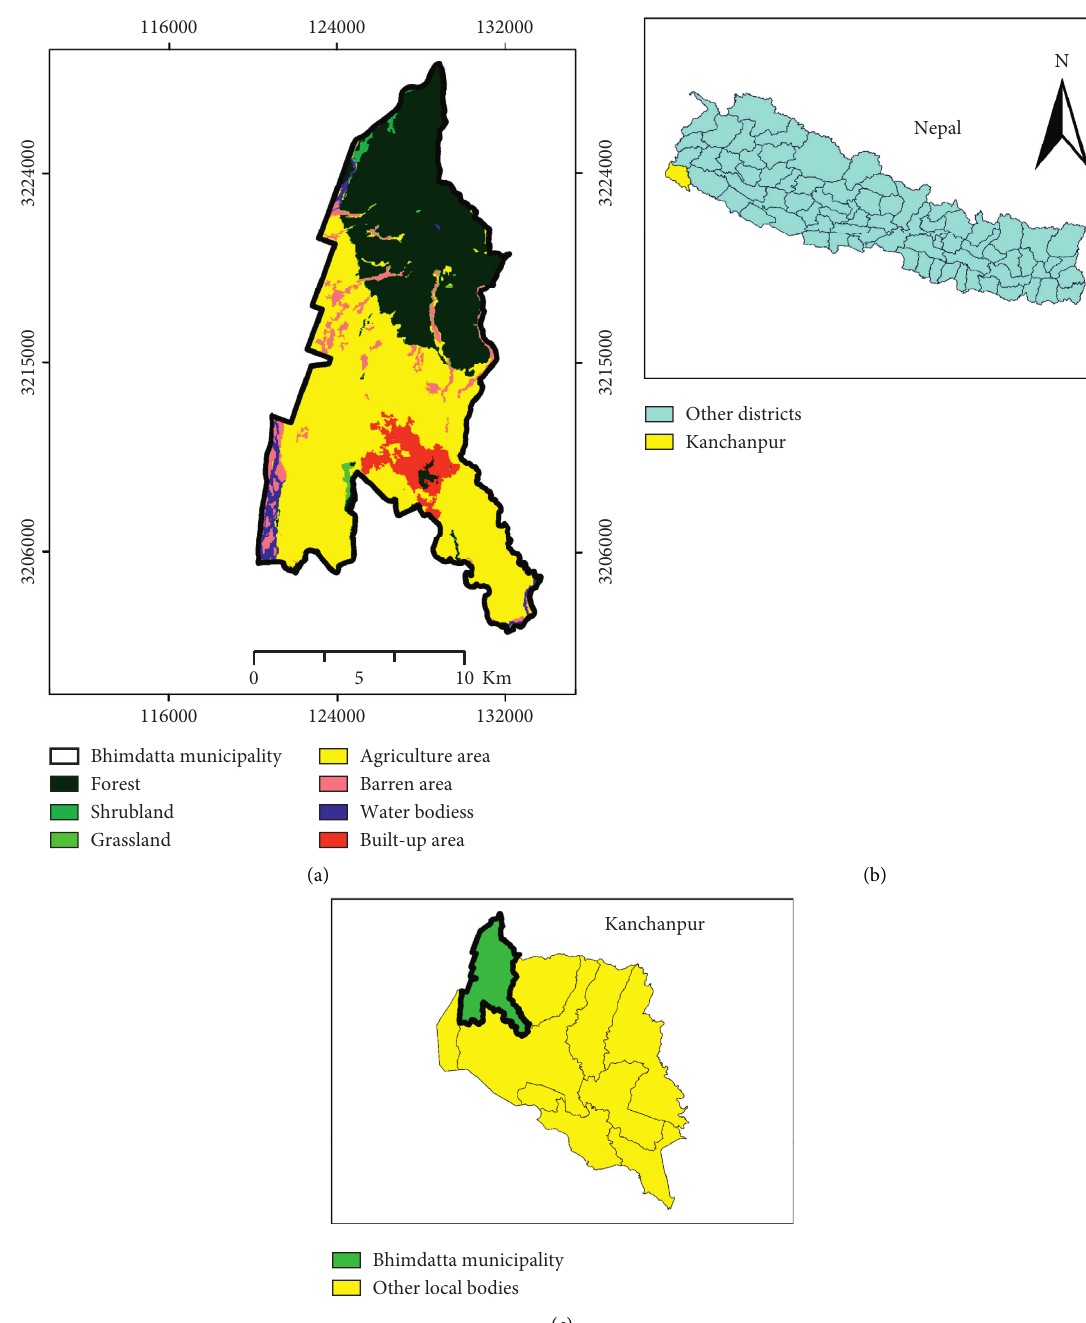
Figure 1: Map of the study